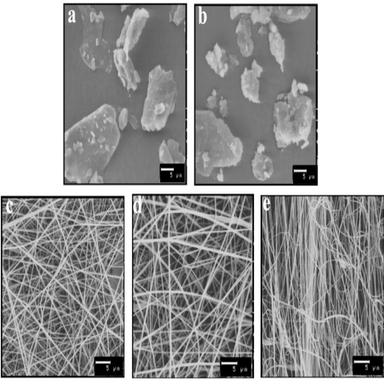
SEM images of a) Av powder b) AvAc powder c) PVP 6 wt% d) Av/PVP 6 wt% e) AvAc/PVP wt 6%.